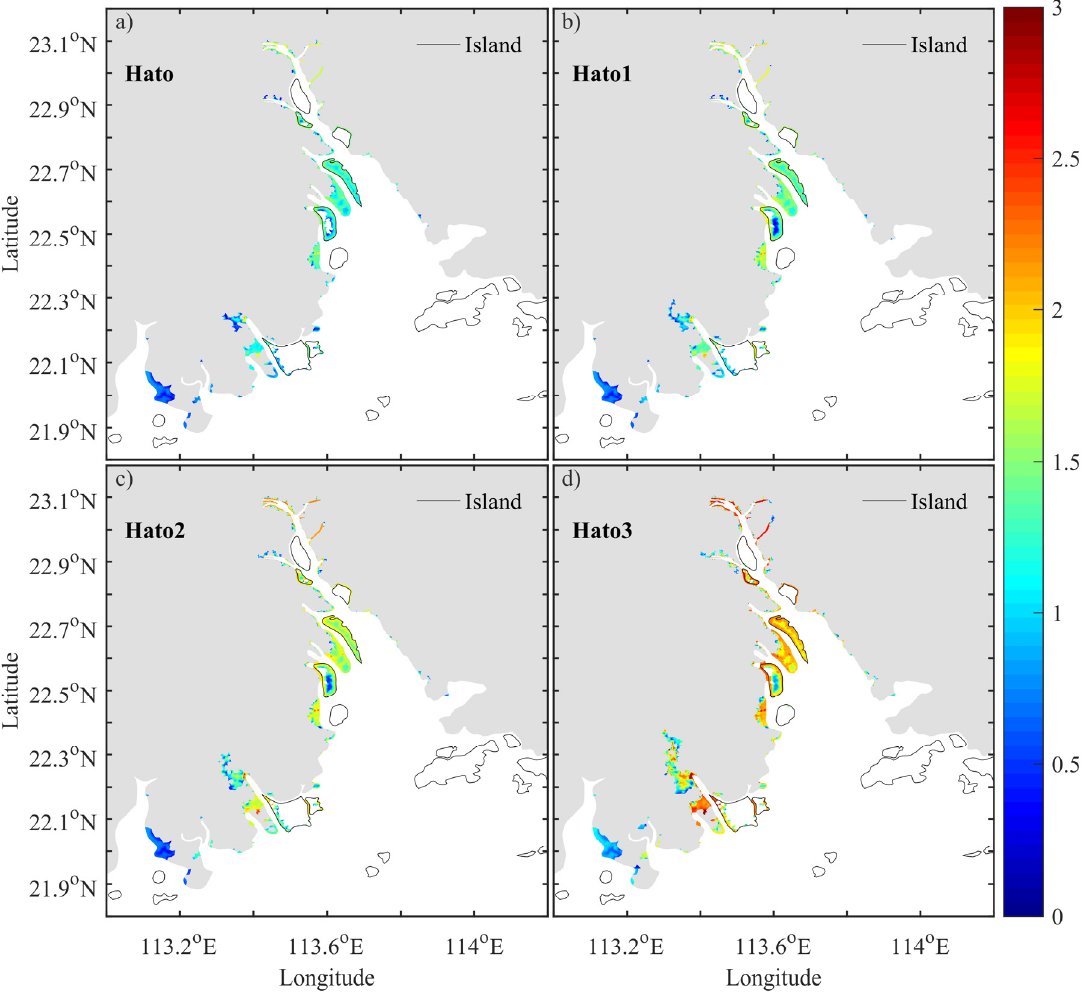
Figure 11. The inundation (units: m; shaded) maps at the PRE based on the simulation results of di ff erent central moving speeds. ( a ): central moving speed of 30 km / h; ( b ): central moving speed of 25 km / h; ( c ): central moving speed of 20 km / h; ( d ): central moving speed of 15 km / h. The color bars of the 4 sub figures are all in the range of 0 m–3 m and displayed in rainbow color.